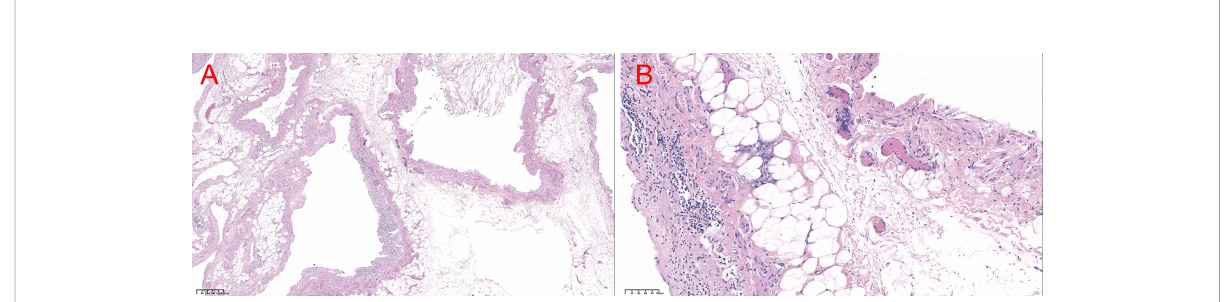
FIGURE 2 HE stains in (A) 40× view and (B) 200× view. Histology of lymphangioma. The cystic wall consisted of fi broconnective tissue accompanied by dilated lymphatic spaces and lymphoid cell aggregations in the endothelial lining of lymphatic vessels (A) H&E ×40, (B) H&E ×200.